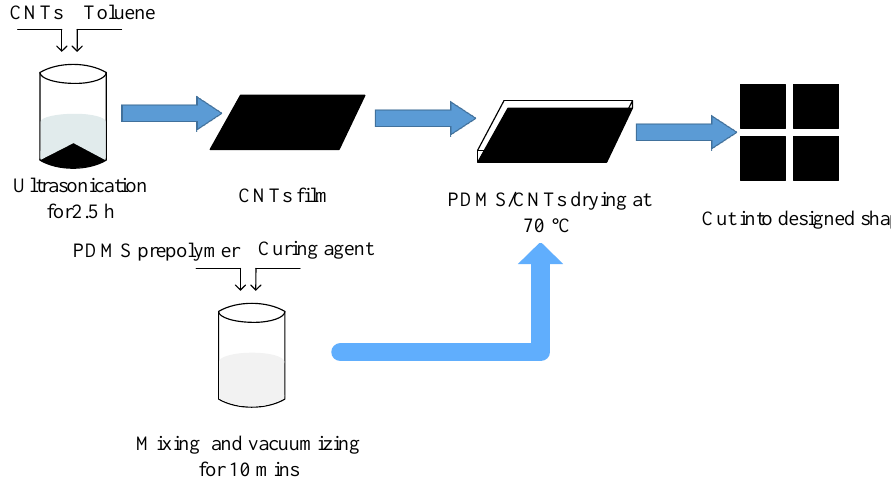
Figure 4. Schematic diagram of electrode layer preparation.